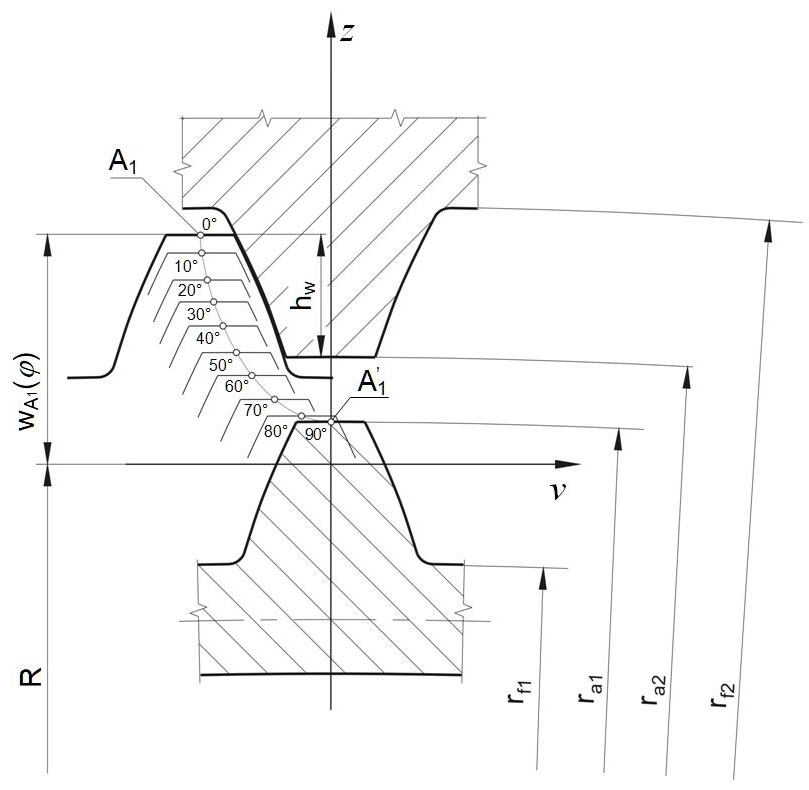
Figure 6. The trajectory of A 1 point of the tooth of flexspline.